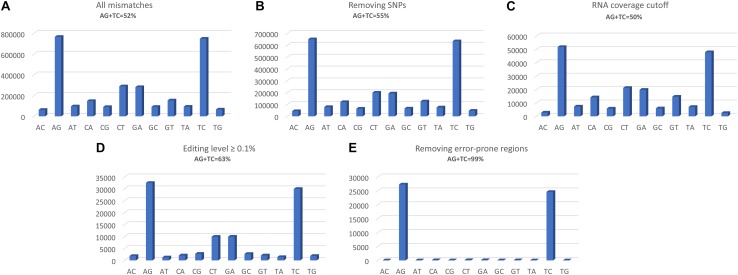
Distributions of RNA variants detected by REDItools obtained following the different filtering steps: (A) all mismatches found following mapping, with a phred quality score of at least 30; (B) selecting only sites supported by at least 10 WGS reads and removing positions in dbSNP; (C) selecting sites covered by at least 10 reads and not falling in homopolymeric stretches longer than five residues or in the first and last six bases of a read; (D) selecting sites with an editing frequency of at least 0.1; (E) excluding sites in mis-mapped reads (by Blat correction) or near splice sites or in genomic regions containing poorly aligned reads.